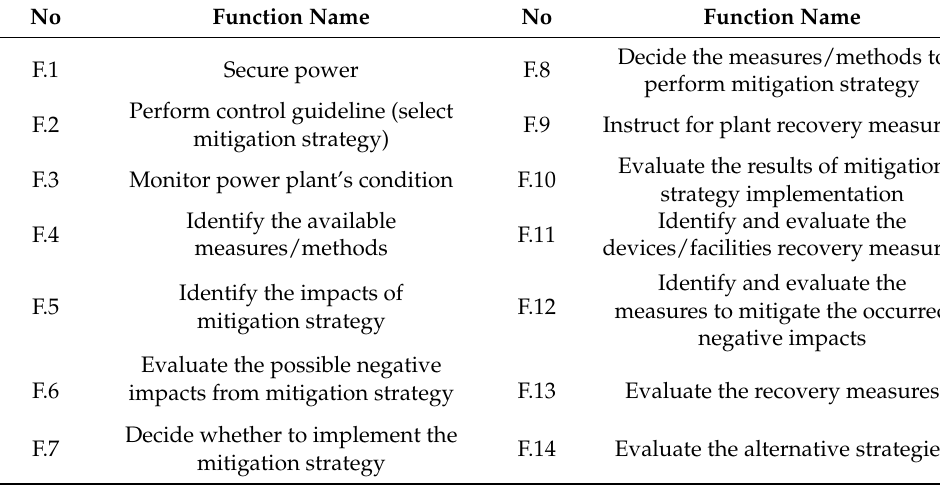
Figure 3. FRAM model of severe accident management of NPPs. The functions related to mitigation strategy execution are marked in a blue border. strategy execution are marked in a blue border. Table 1. List of functions from FRAM Modeling Results. Table 1. List of functions from FRAM Modeling